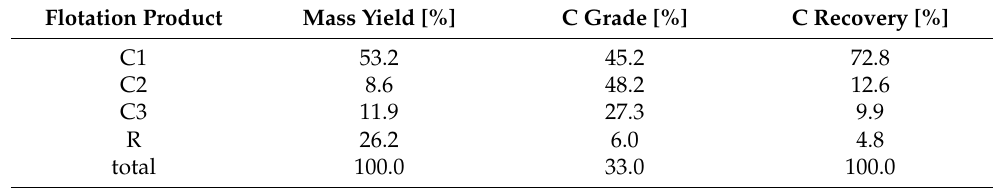
Table 3. Balance of the preliminary flotation test. C1 to C3: carbon concentrates; R: